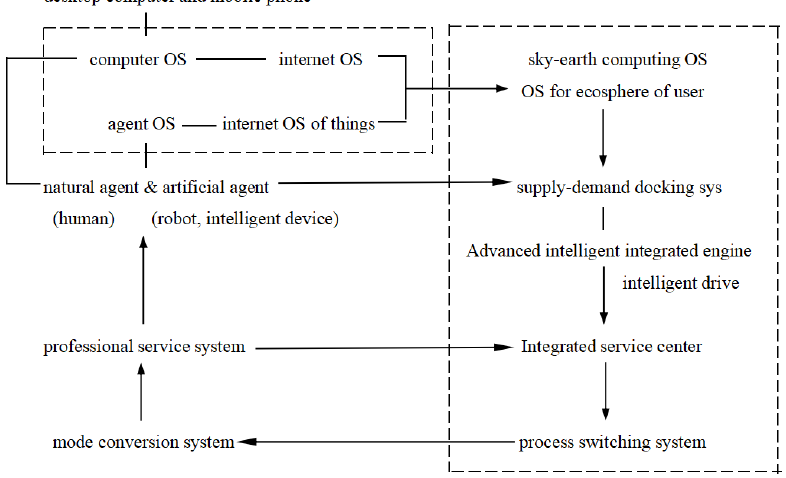
Fig. 4. Conception of sky-earth computing operating system with each user as